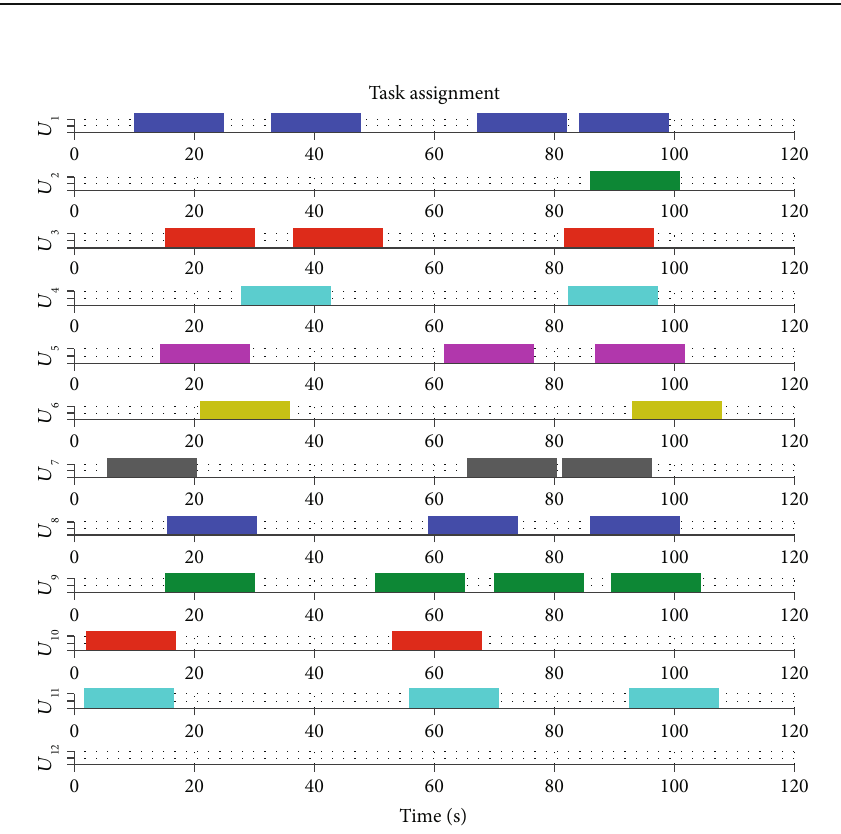
Figure 6: The task assignment obtained by the CBBA algorithm of